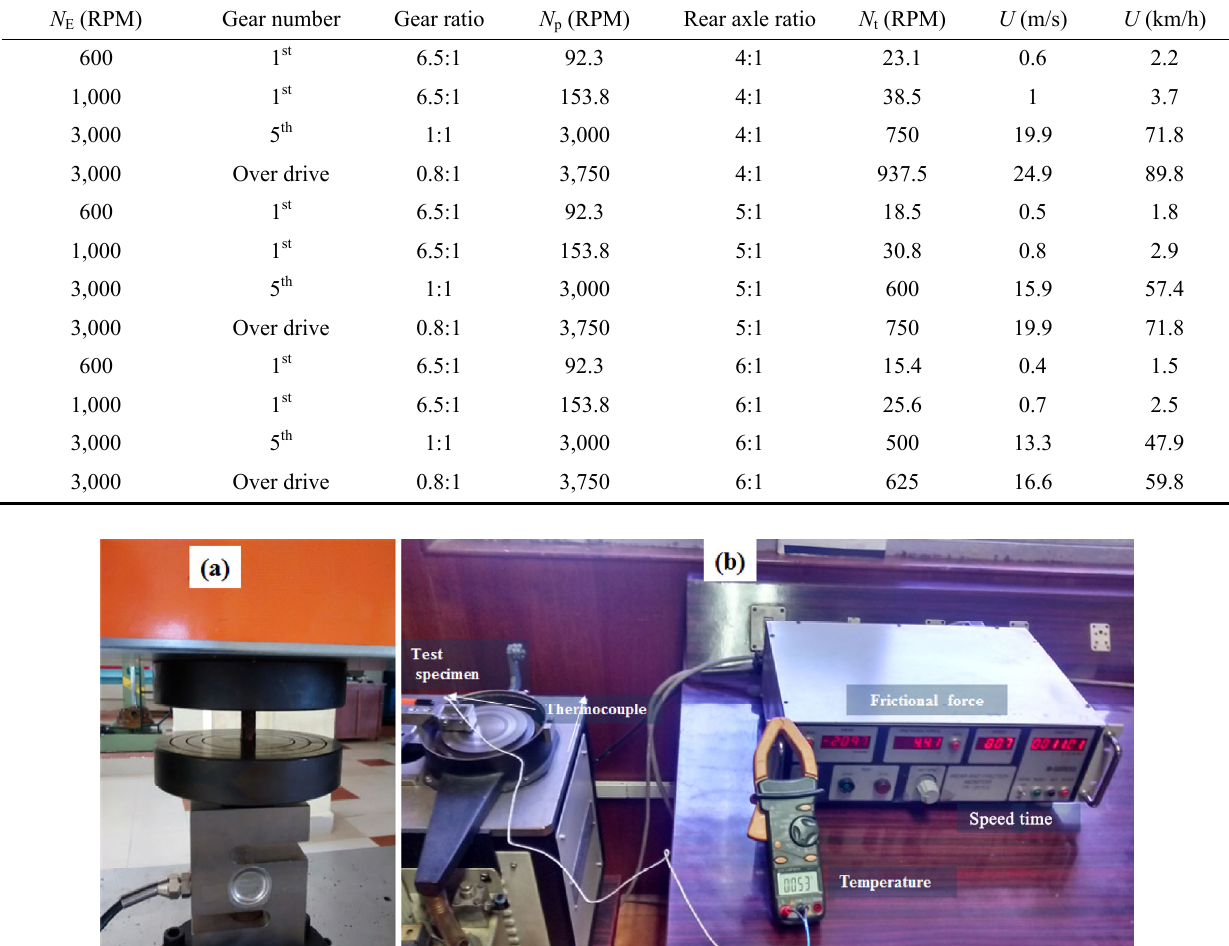
Table 3 Estimation of wheel speed “ N t ” and vehicle speed “ U ”.